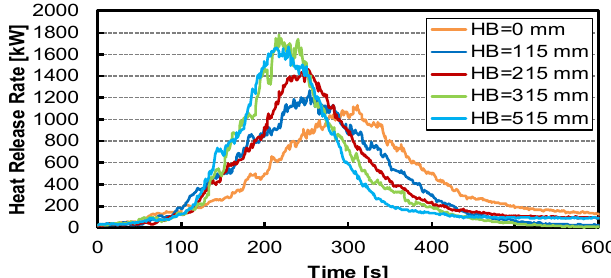
Figure 4. HRRs of the mattresses under different installation conditions.